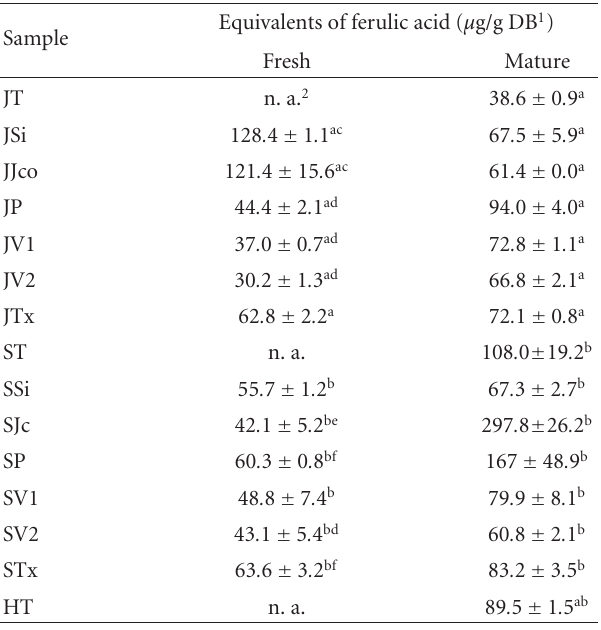
Table 5: Total content of phenolic compounds in the chilli varieties under